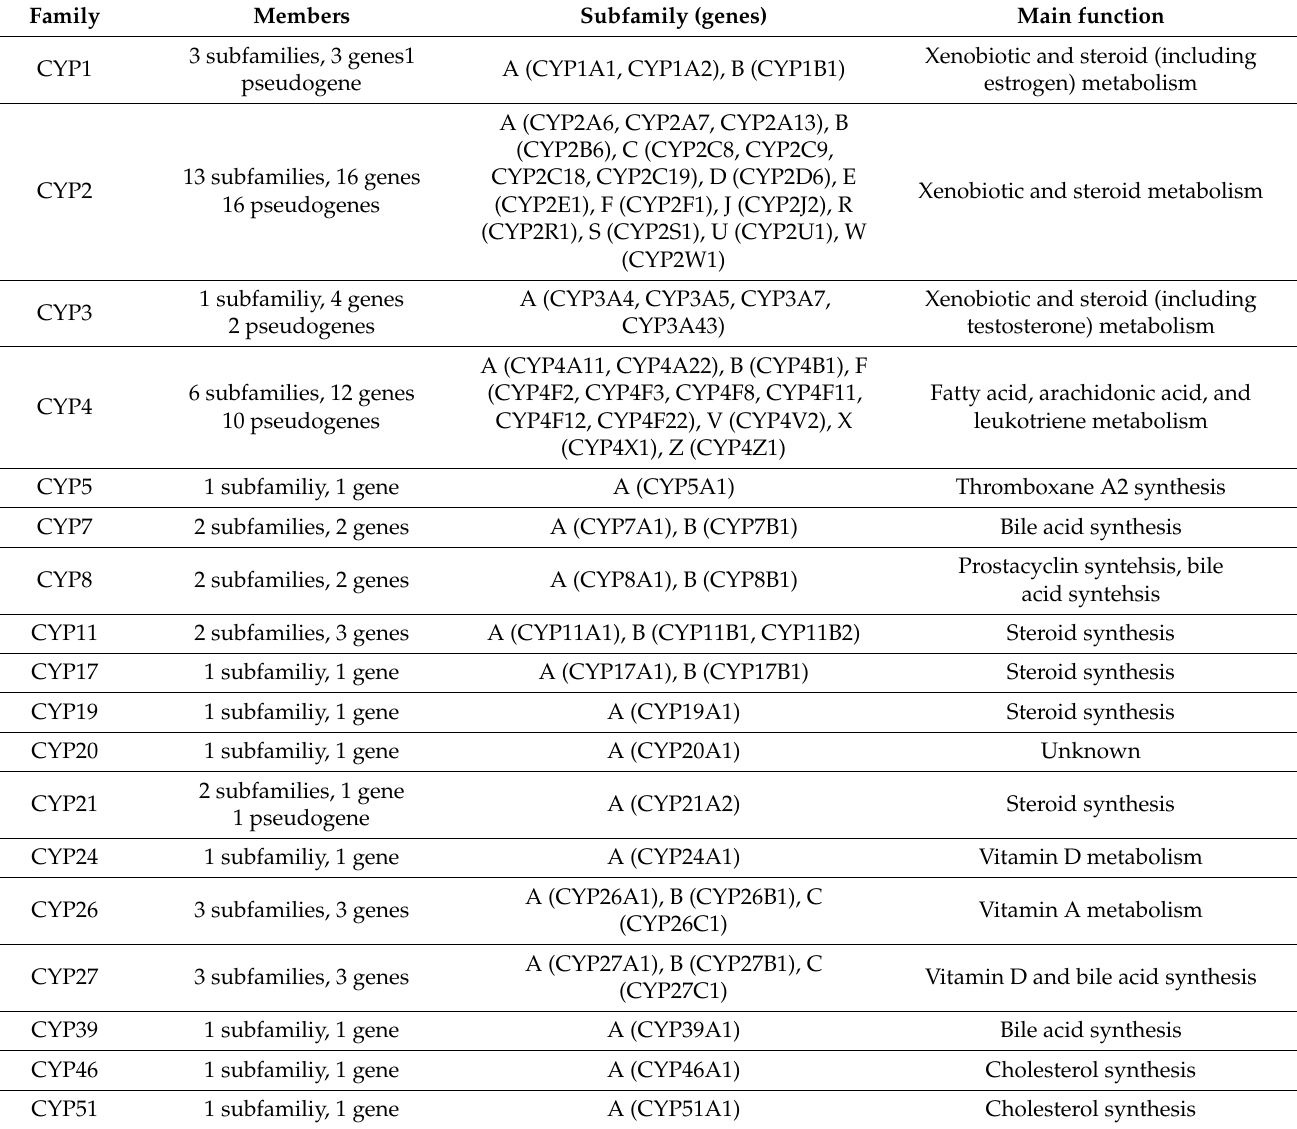
Table 1. Cytochrome P450 families and their main functions. Adapted from